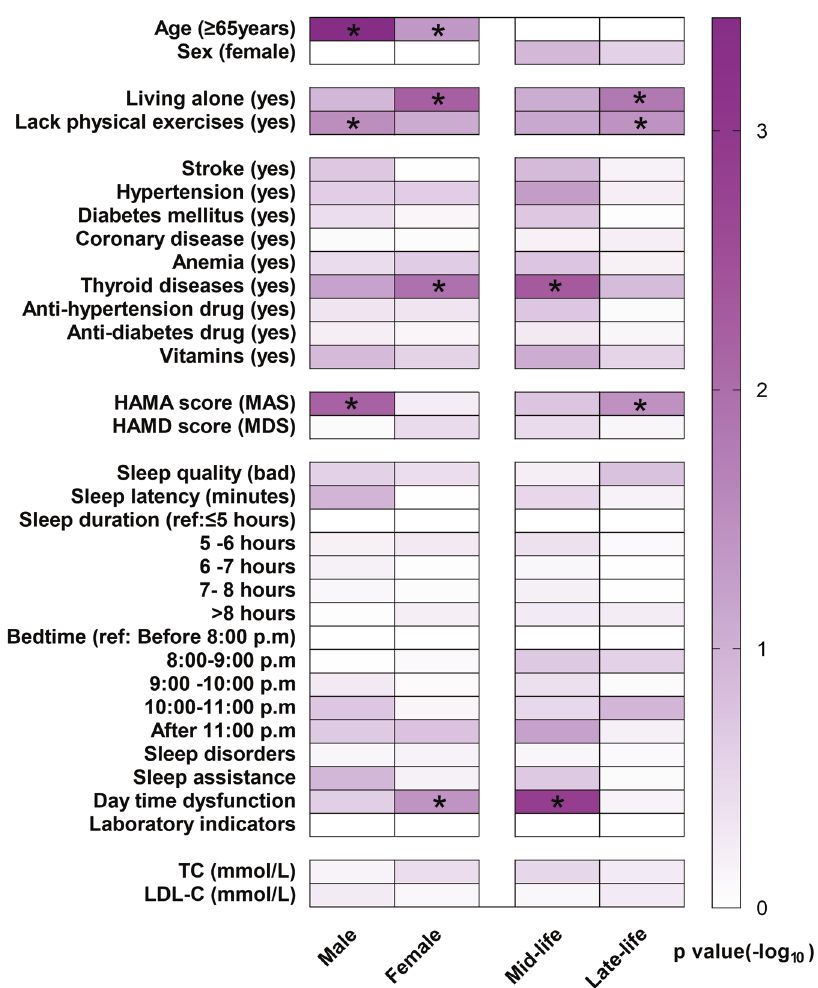
Fig. 2 Subgroup analyses by age and sex. Multivariate logistic regression was used to test associations between factors and SCD. Abbreviations: TC: total cholesterol; LDL-C: low-density lipoprotein cholesterol; HAMA: Hamilton anxiety scale; MAS: minimal anxiety symptoms; HAMD: Hamilton depression scale; MDS: minimal depression symptoms.